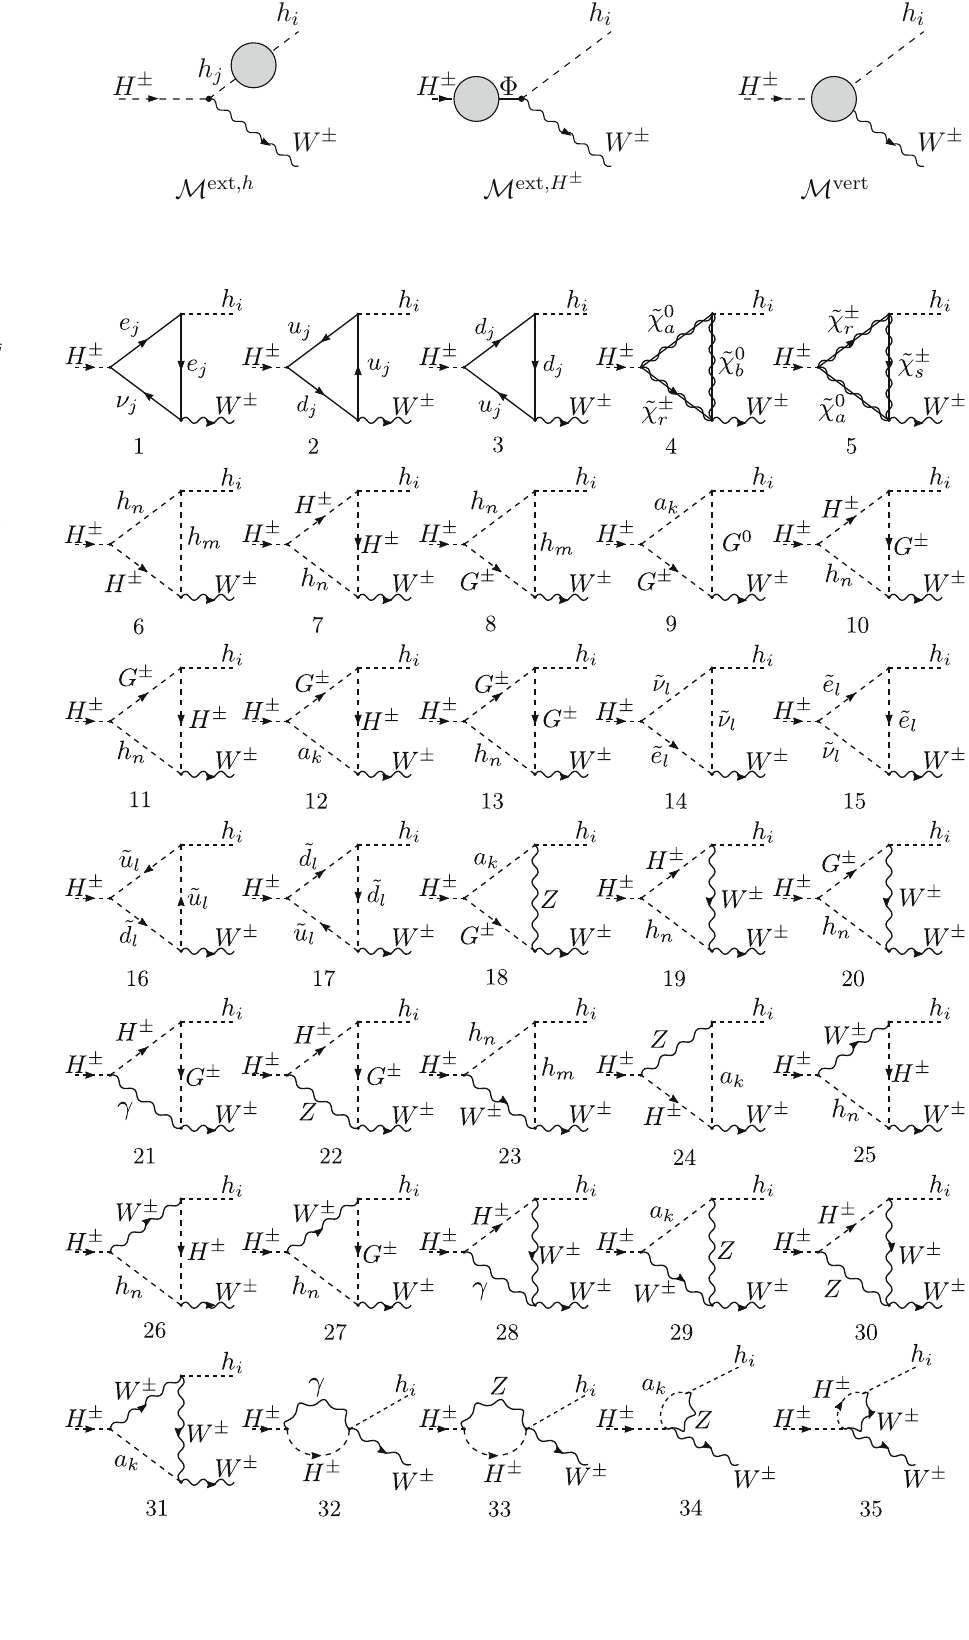
contributing to the pure vertex corrections at NLO. Here u j , d j denote up- and down-type quarks and ν j , e j neutrinos and charged leptons for all three generations ( j = 1 , 2 , 3), ˜ u l , ˜ d l denote up- and down-type squarks and ˜ e l , ˜ ν l denote charged sleptons and sneutrinos ( l = 1 ,..., 6), a k ( k = 1 , 2) denote the pseudoscalar and h i , m , n ( i , m , n = 1 , 2 , 3) the scalar Higgs bosons, and ˜ χ 0 a ,